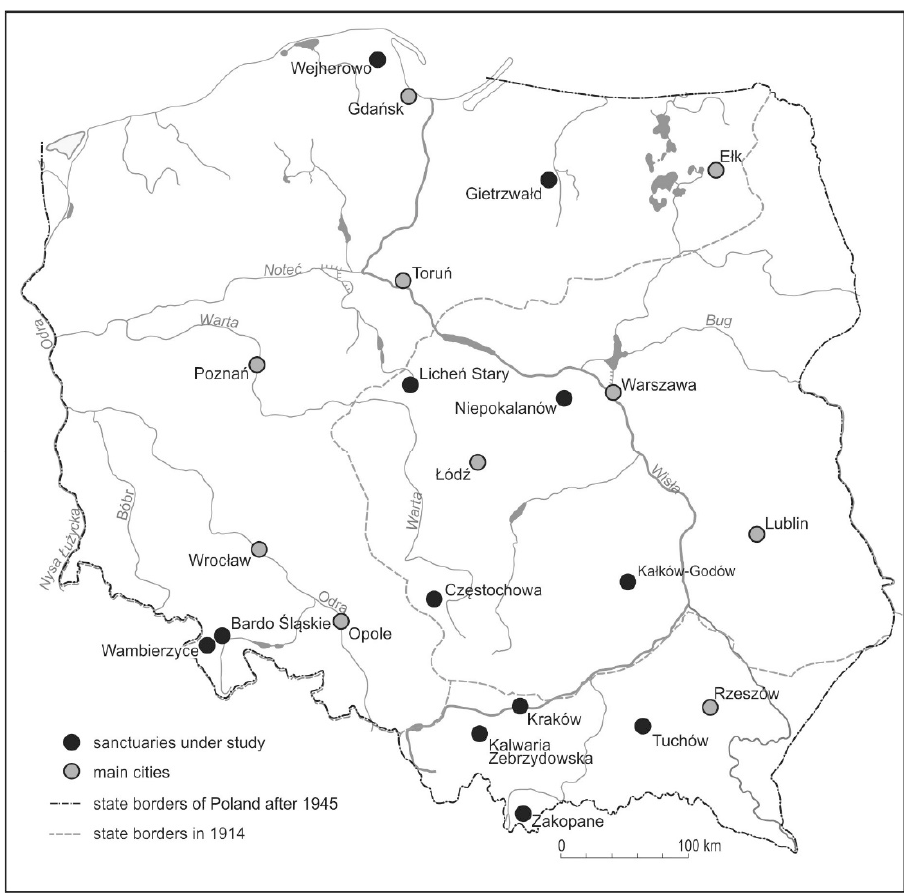
Figure 1. Location of the analysed sanctuaries within the historical borders of Poland. Source: Authors own study.